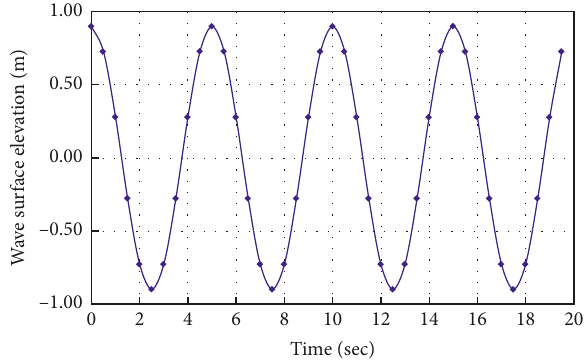
Figure 4: Regular wave surface